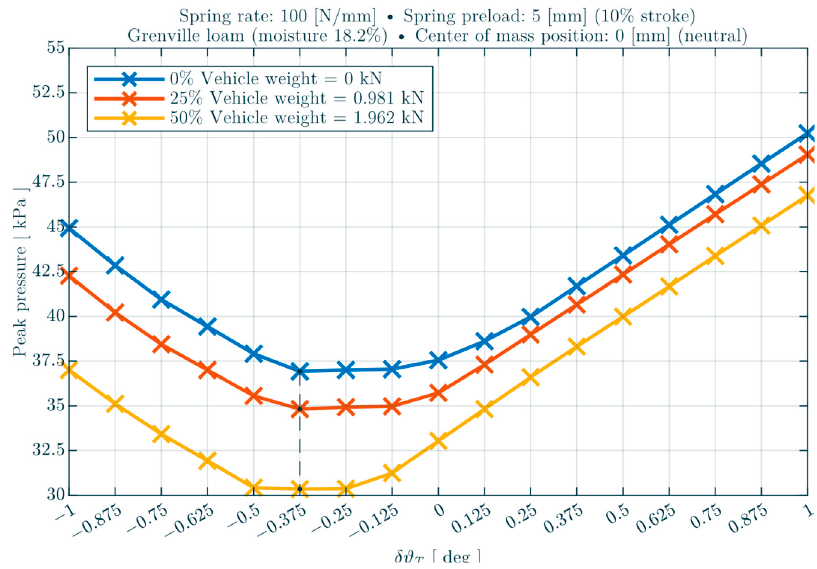
Figure 22. Peak pressure beneath the track module as a function of δϑ T : chain tension effect.